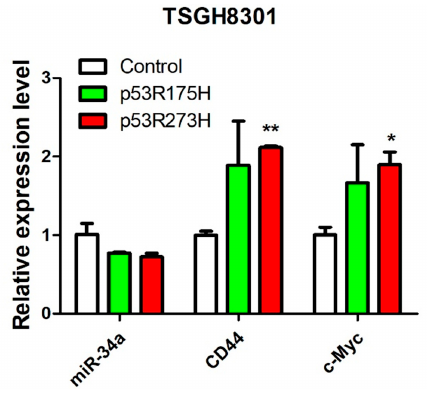
Figure 7. p53 controls miR-34a expression in TSGH8301 urothelial carcinoma cells. Co-expression of p53 mutants p53R175H or p53R273H, with wild-type p53, in TSGH8301 cells, downregulated miR-34a and upregulated CD44 and c-Myc , as determined by RT-PCR. * p < 0.05; ** p < 0.01.